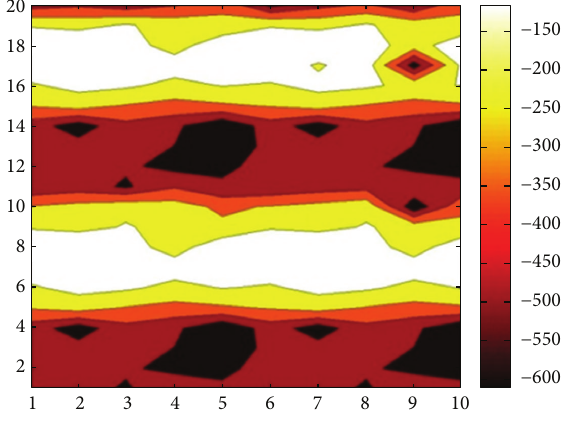
Figure 4: Half-cell potential